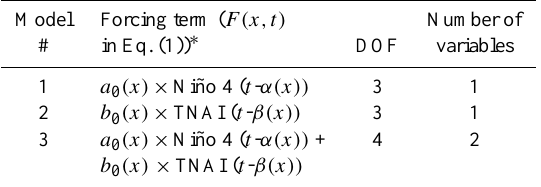
Table 1. Description of the three models: parameters, predictor vari- ables, degrees of freedom, and number of variables. Model Forcing term ( F(x,t) Number